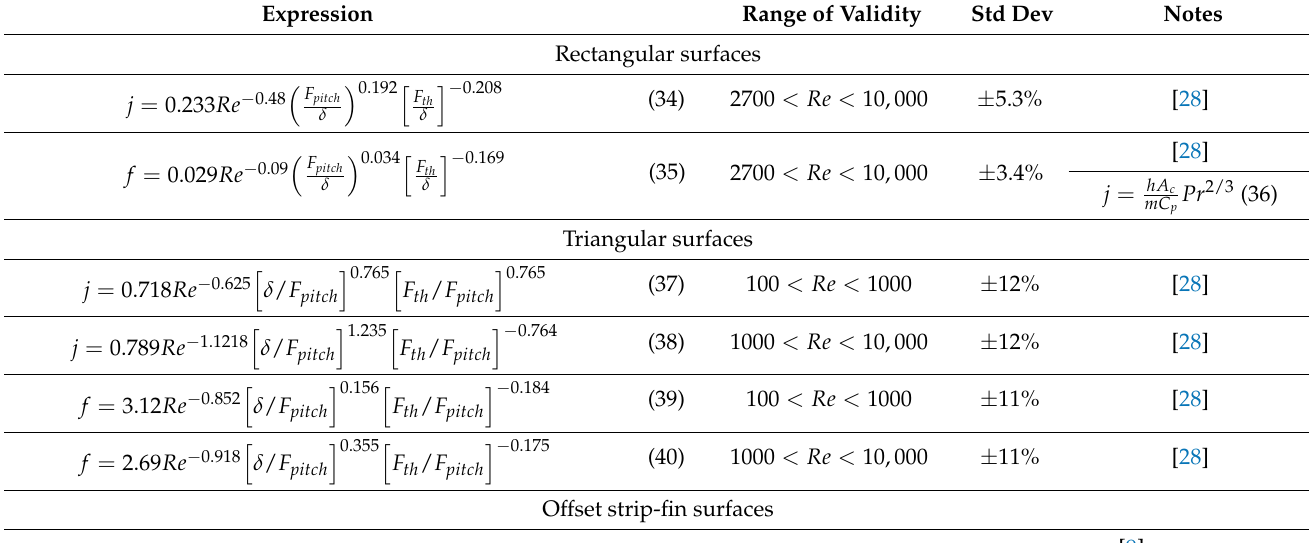
Table 3. Correlations for several heat transfer